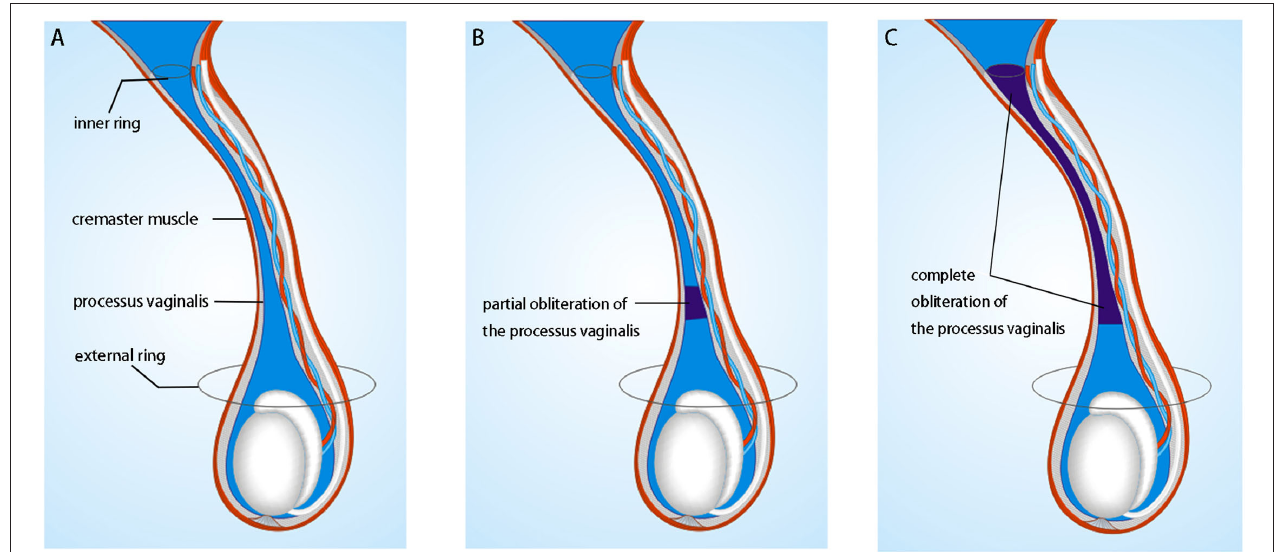
FIGURE 1 | Schematic drawing showing the intraoperative findings of the processus vaginalis: (A) wholly open if a communication existed from the inner ring to the tunica vaginalis of the testis; (B) partially open when it opened at the internal ring but obliterated distally before reaching the testis; (C) complete obliteration from the internal ring to the upper extent of the tunica vaginalis.